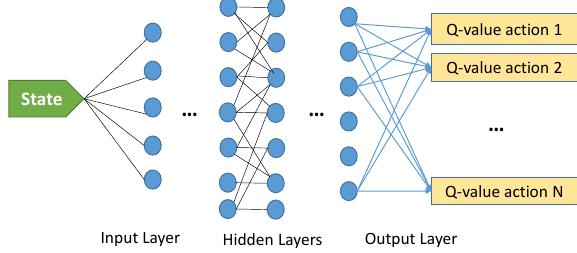
Figure 2. Deep Q-learning